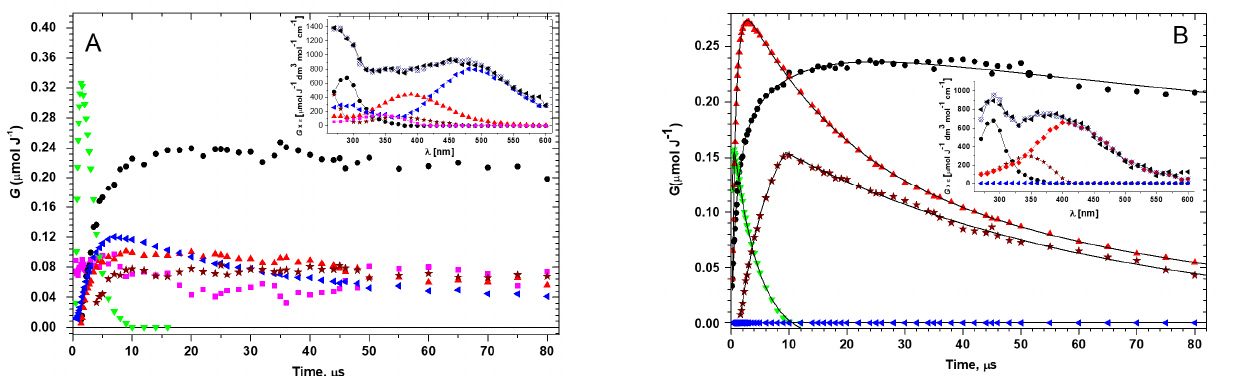
Figure 2. ( A ) Concentration profiles of transients formed in the reaction of HO • radicals with Met derivative 1 : HOS • ( ), αC(1) • ( ), αS • ( ), SS •+ ( ), SN • ( ), and αC(2) • ( ); Inset, resolution of the spectral components: αC(1) • ( ), αS • ( ), SS •+ ( ), SN • ( ), αC(2) • ( ), fit ( ), and experimental ( ) in the transient absorption spectrum recorded 10 µs after the electron pulse in N 2 O-saturated aqueous solutions containing 1 at pH 7. ( B ) Concentration profiles of transients formed in the reac- tion of HO • radicals with cysteine-methylated derivative 2 : HOS • ( ), αS • ( ), SS •+ ( ), SO •+ ( ), and αC(2) • ( ); Inset, resolution of the spectral components: αS • ( ), SS •+ ( ), SO •+ ( ), αC(2) • ( ), fit ( ), and experimental ( ) in the transient absorption spectrum recorded 10 µs after the elec- tron pulse in N 2 O-saturated aqueous solutions containing 2 at pH 7. Table 1. The radiation chemical yields ( G , µmol J −1 ) of radicals and their percentage contribution (in parenthesis) to the total yield of radicals present in the reaction of HO • with Met-containing derivative 1 at different times after the electron pulse at pH 7.